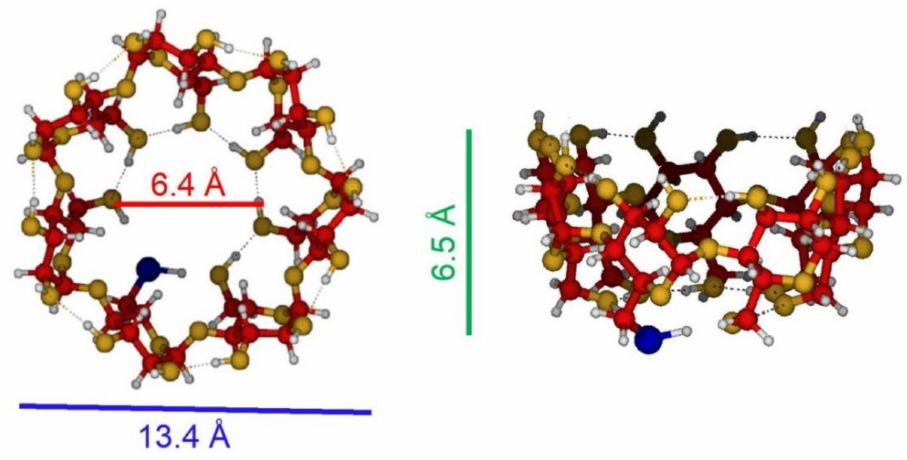
Figure 2. B3LYP/LanL2DZ optimized geometry of 6-deoxy-6-thio- β -cyclodextrin